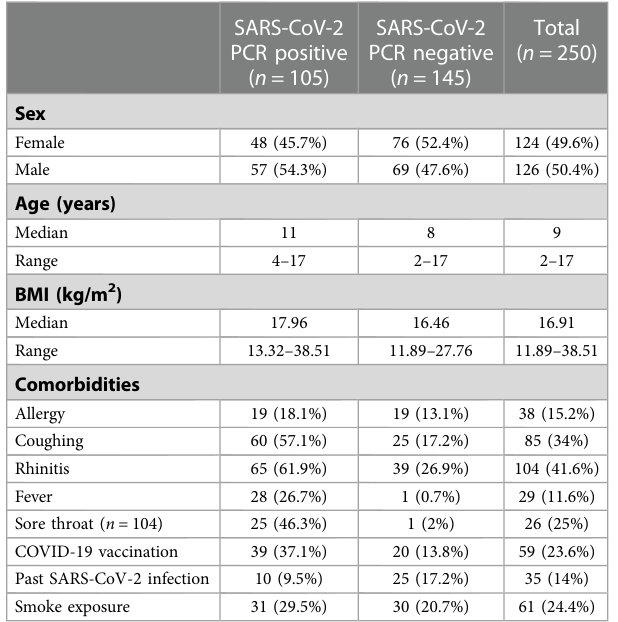
TABLE 1 Characteristics of severe acute respiratory syndrome coronavirus 2 (SARS-CoV-2) polymerase chain reaction (PCR)-positive and PCR- negative children and